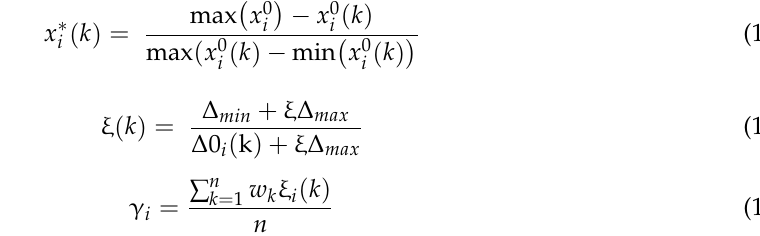
Table 5. Grey relational coefficient (GRC) and grey relational grade (GRG) for MQL-grinding. No. GRC of Surface Roughness GRC of Temperature GRC of Normal Force GRG 1